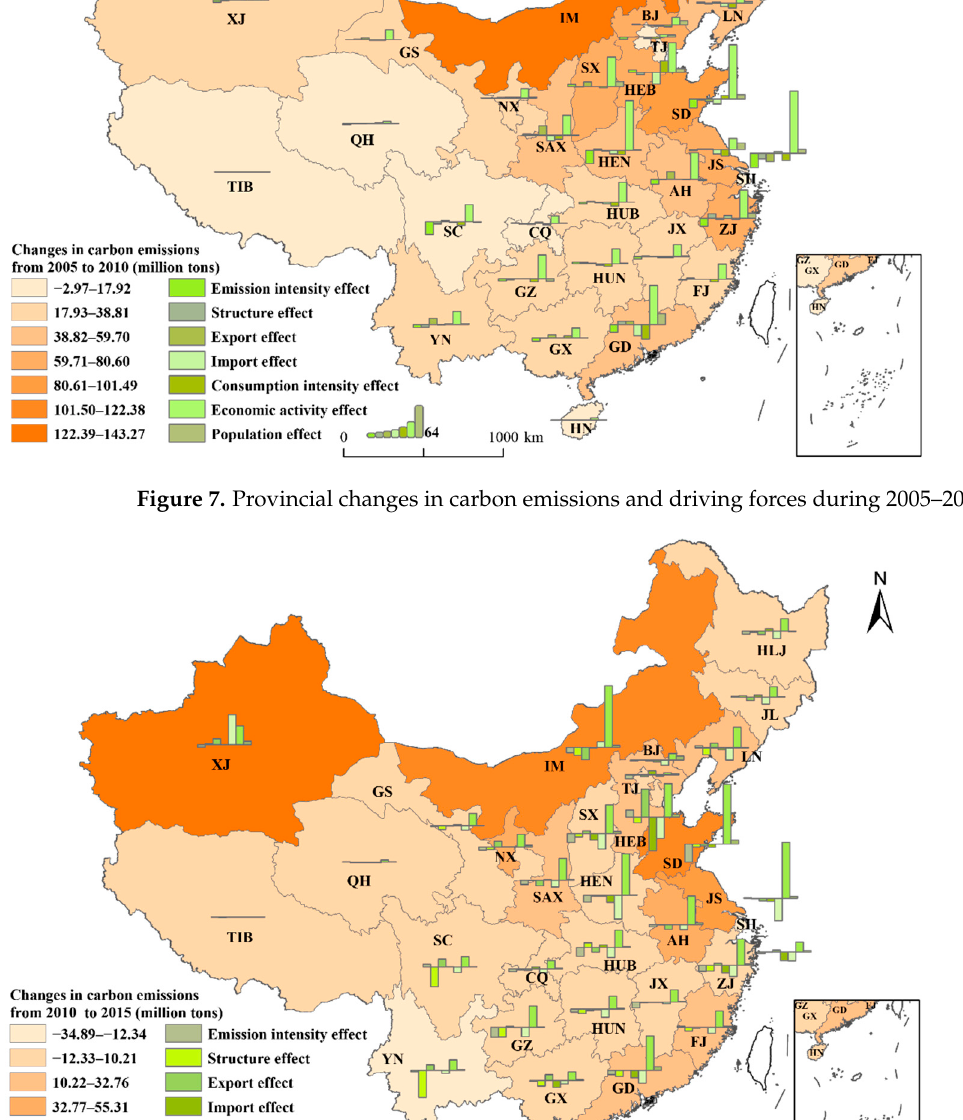
Figure 7. Provincial changes in carbon emissions and driving forces during 2005–2010.